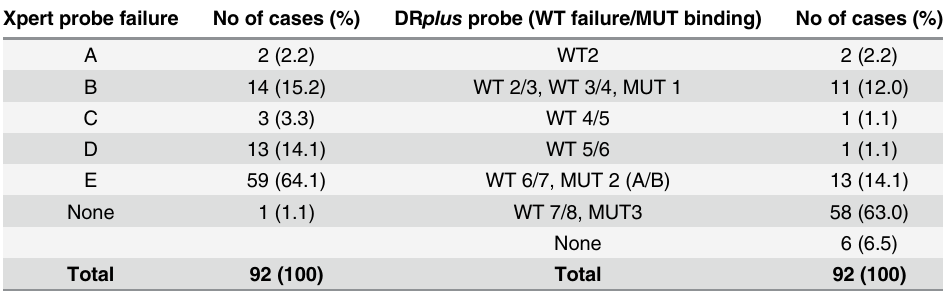
Table 3. Probe hybridization pattern of two molecular DST methods.